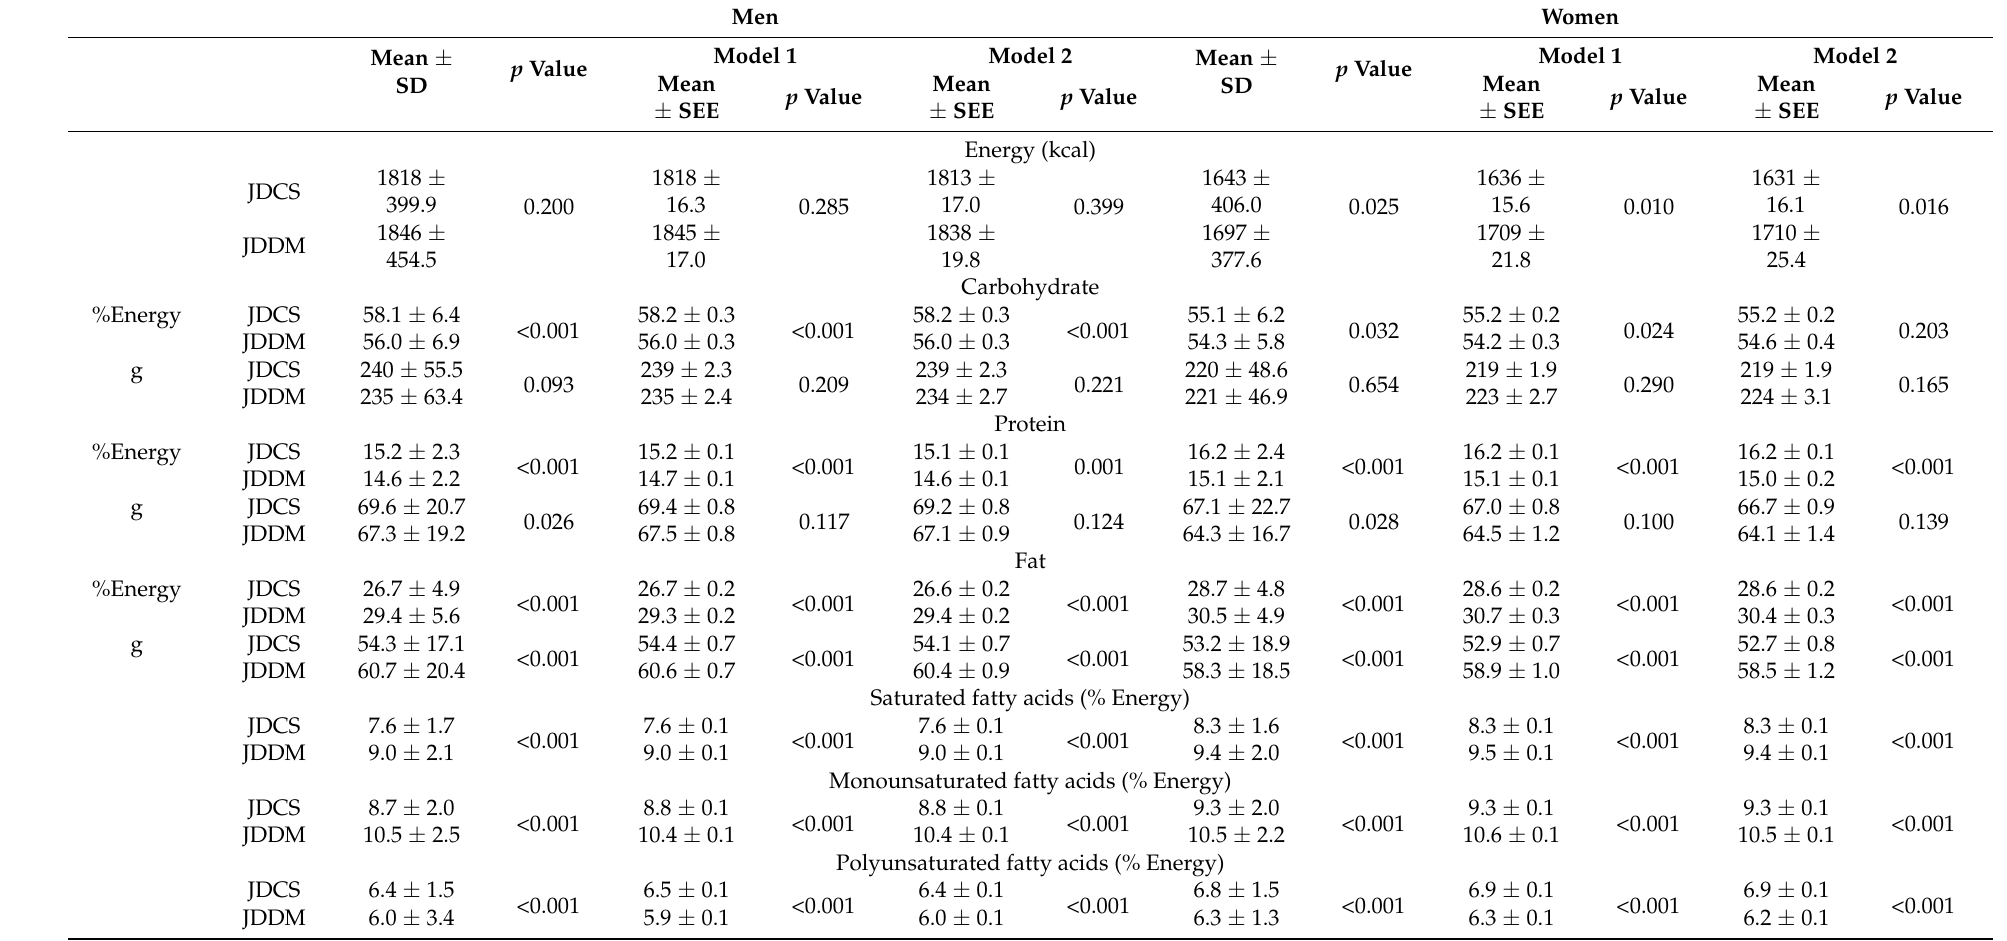
Table 2. Comparison of each nutrient intake in male and female participants of JDCS (1996) and JDDM